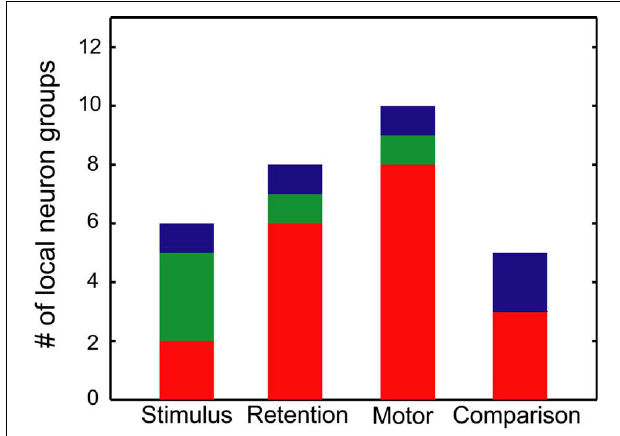
FIGURE 9 | Relation between SSSs and rate modulations. The number of local neuron groups with signifi cant SSSs and rate modulations is shown in relation to stimulus, retention, motor and comparison events. Red signifi es the groups in which more than one pair of neurons showed SSSs that are associated with fi ring rate modulations of at least one of the participating neurons in relation to each behavioral event. Green signifi es the groups in which more than one pair of neurons showed SSSs in relation to each behavioral event, even when no pair exhibited fi ring rate modulations. Blue signifi es the groups in which more than one pair of neurons modulated their fi ring rates, even when no pair exhibited